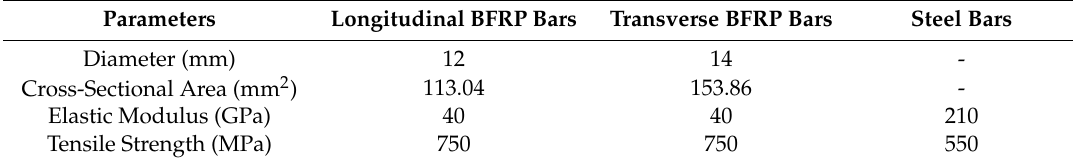
Table 1. Geometric and mechanical properties of BFRP and steel reinforcement.